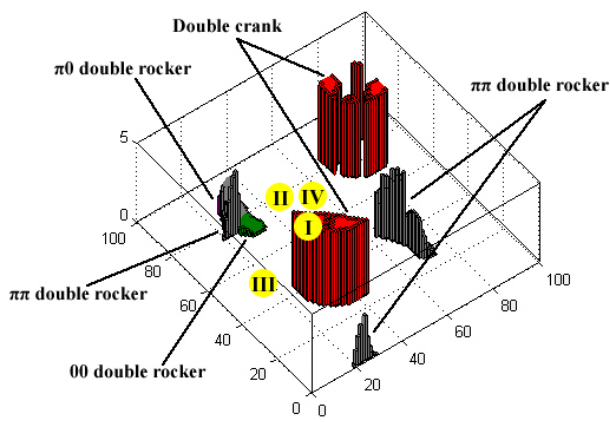
Figure 9. Solutions map generated by the program